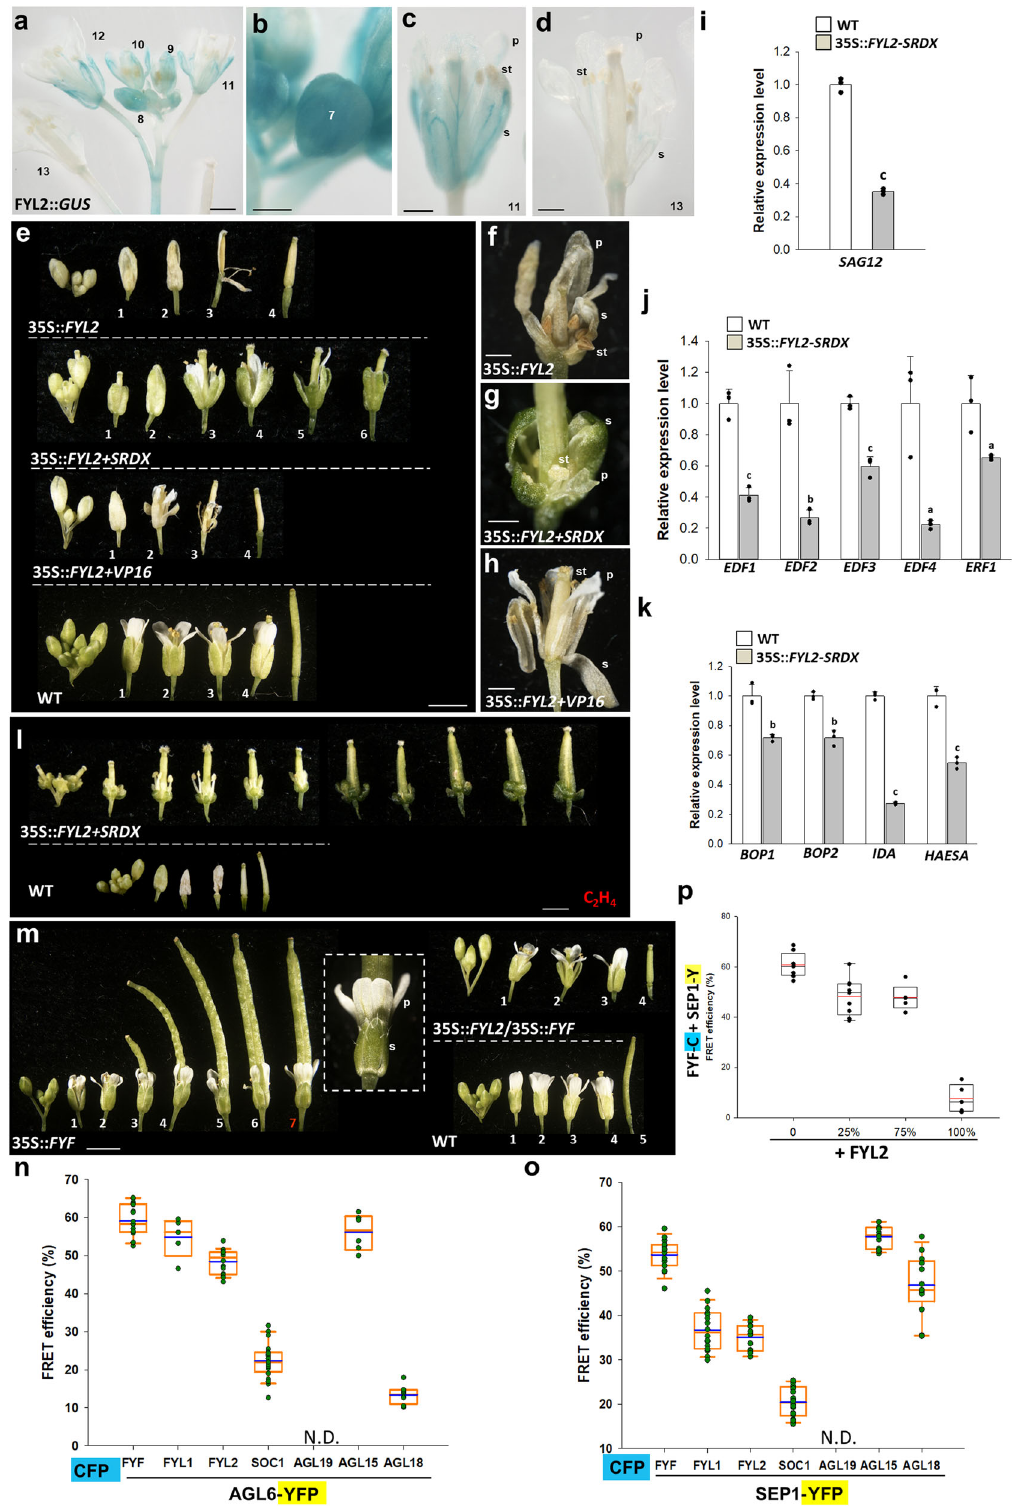
supports the notion that AGL15/AGL18 function similarly to FYF/FYL1 as repressors 39 in regulating fl ower organ abscission. To further explore whether AGL15/AGL18 could also interact with proteins similar to FYF/FYL1 in regulating fl ower organ abscission, FRET analyses were performed. The results indicated that AGL15/AGL6 are able to form heterodimers with